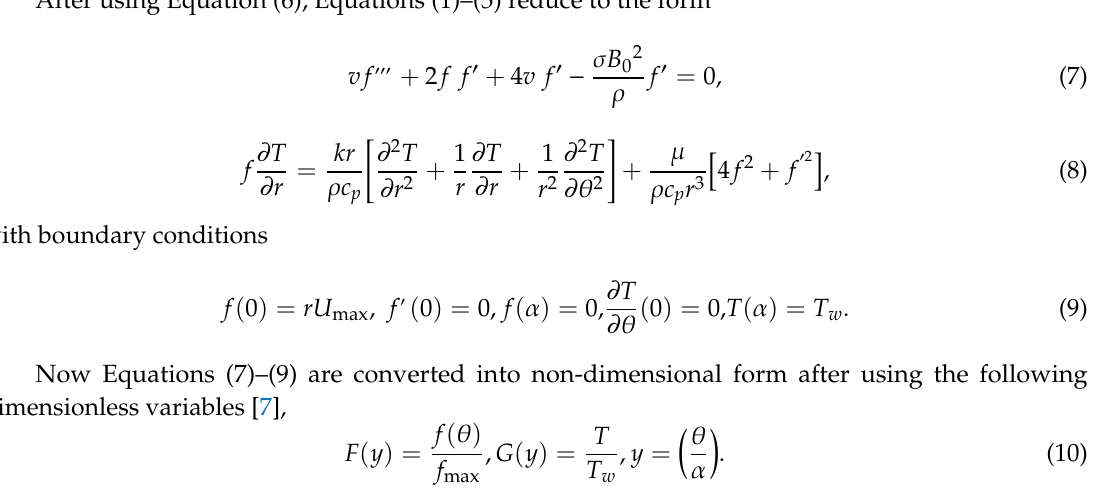
Figure 1. Jeffery-Hamel flow in a converging/diverging channel with angle 2 Figure 1. Je ff ery-Hamel flow in a converging / diverging channel with angle 2 α (Adapted from et al. [12]). Motsa, et al.